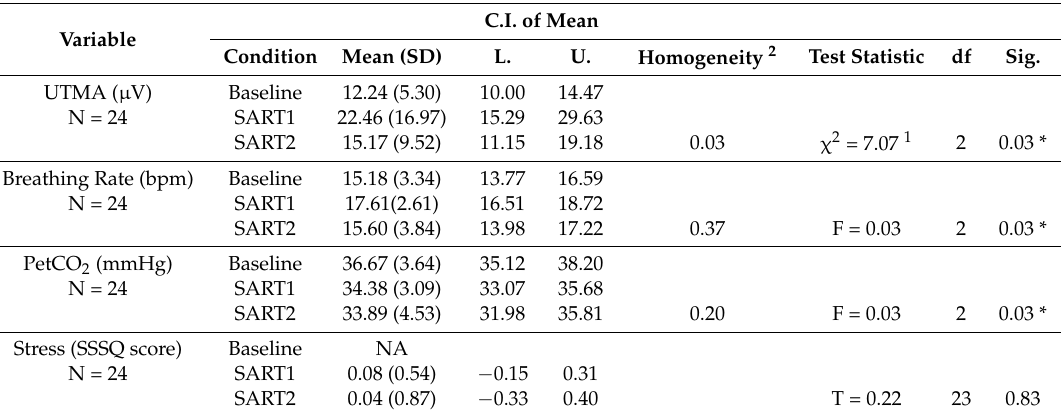
Table 1. Descriptive statistics of study variables.